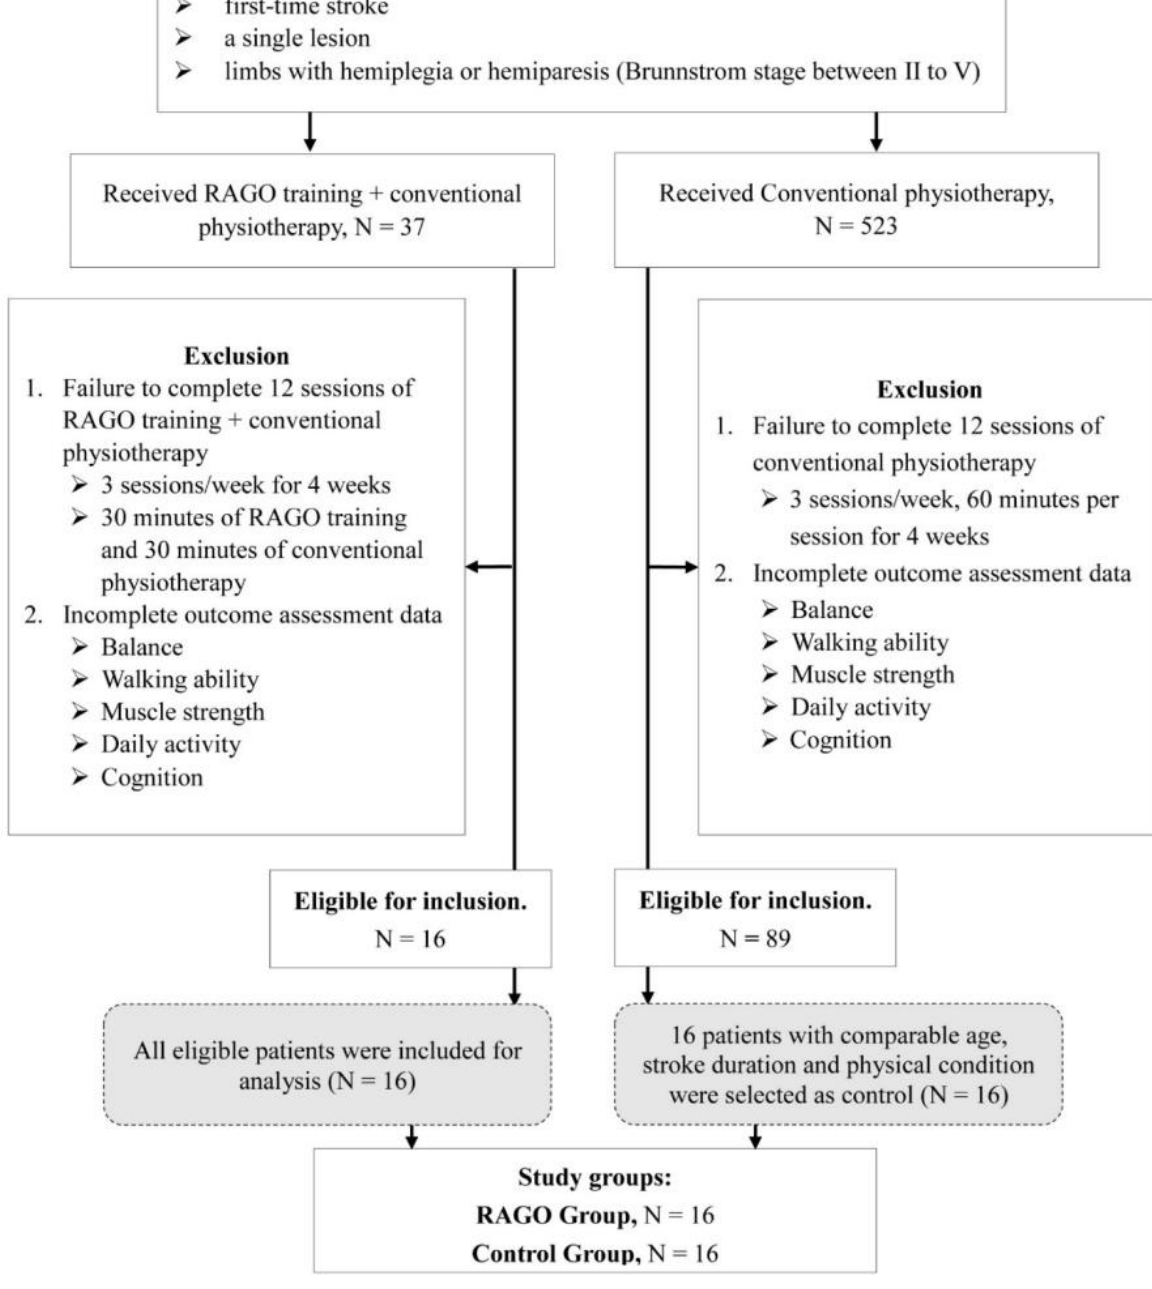
Figure 1. Study flow chart. Abbreviation: RAGO, robot-assisted gait